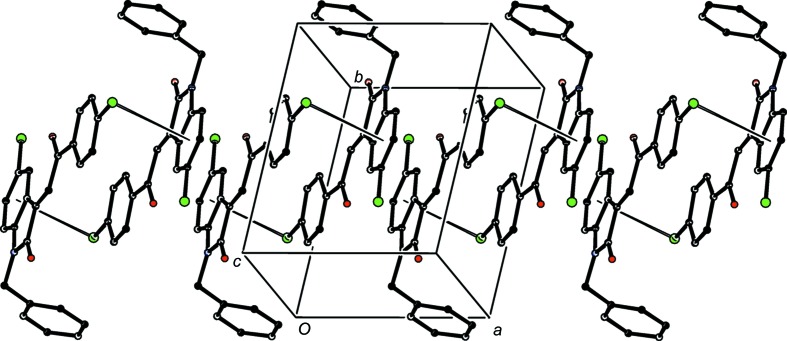
Part of the crystal structure of com­pound (IIh), showing the formation of a chain of π-stacked dimers running parallel to the [100] direction. The Cl⋯(ring centroid) contacts are shown as tapered lines and, for the sake of clarity, H atoms have all been omitted.